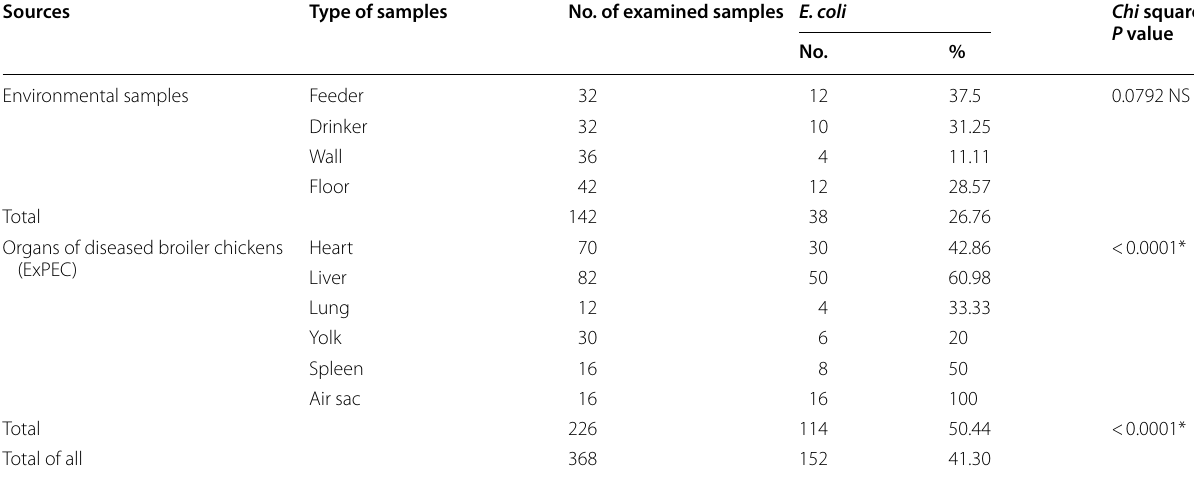
%The percentage was calculated according to the no. of each type of samples